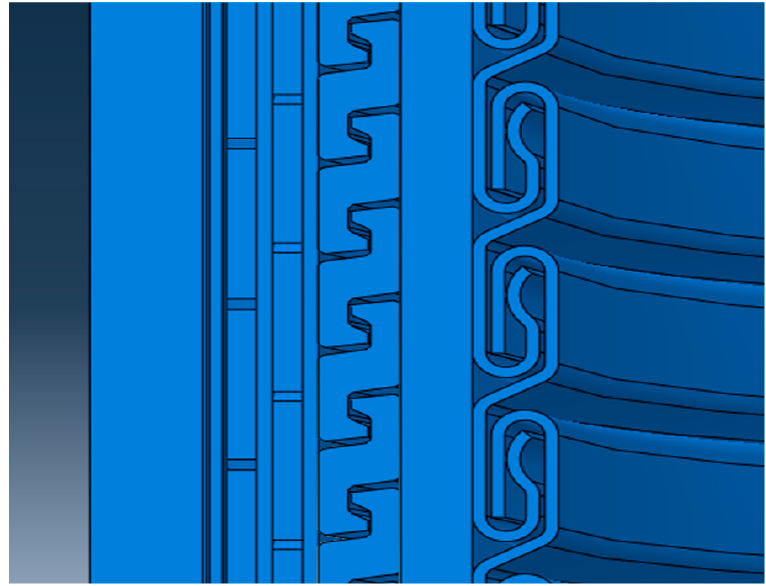
Figure 4. A finite element model of a multilayer flexible riser.